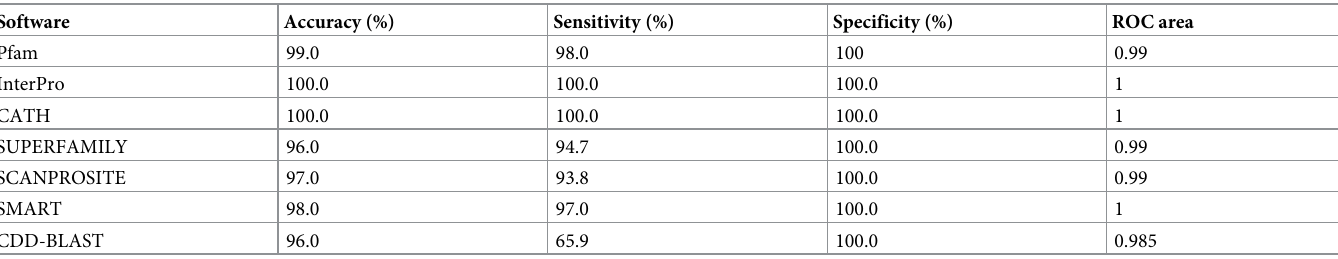
Table 2. ROC results of the tools used in this